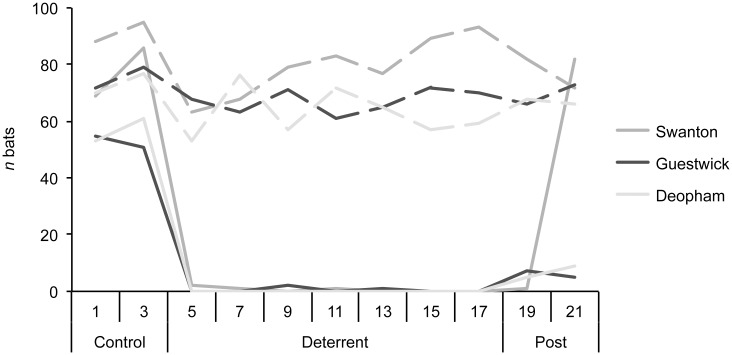
Response of Myotis nattereri to long-term applications of the Deaton (ultrasound) device.The figure shows the number of bats roosting inside the church (dashed lines) and in the roost above the deterrent (solid lines) each day at three churches during the control (deterrent off), deterrent (deterrent on) and post-deterrent (deterrent off) periods.